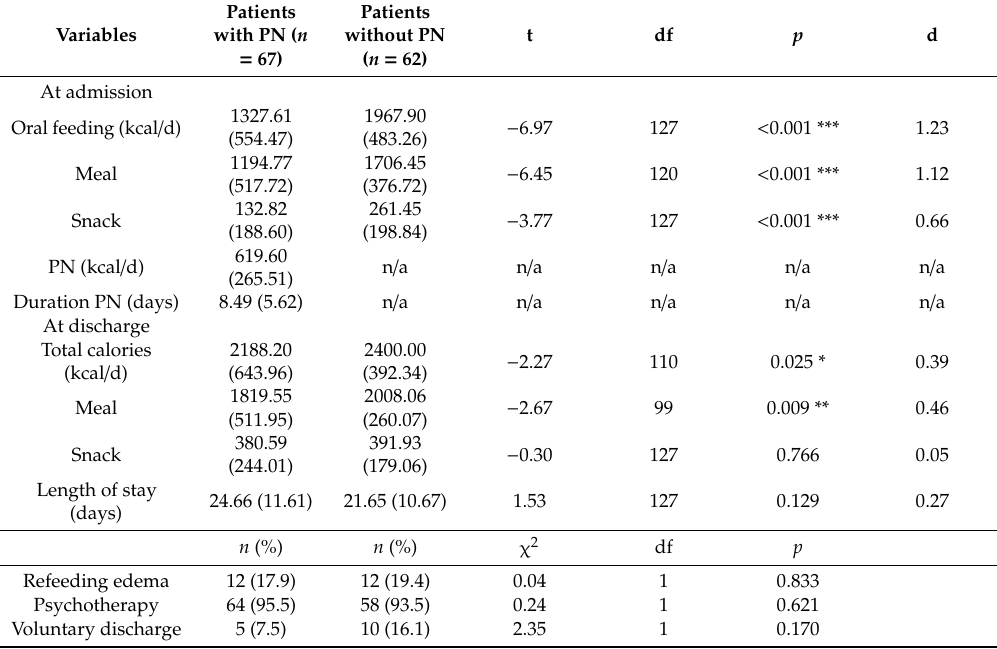
Table 2. Nutritional therapy for AN patients with and without PN during